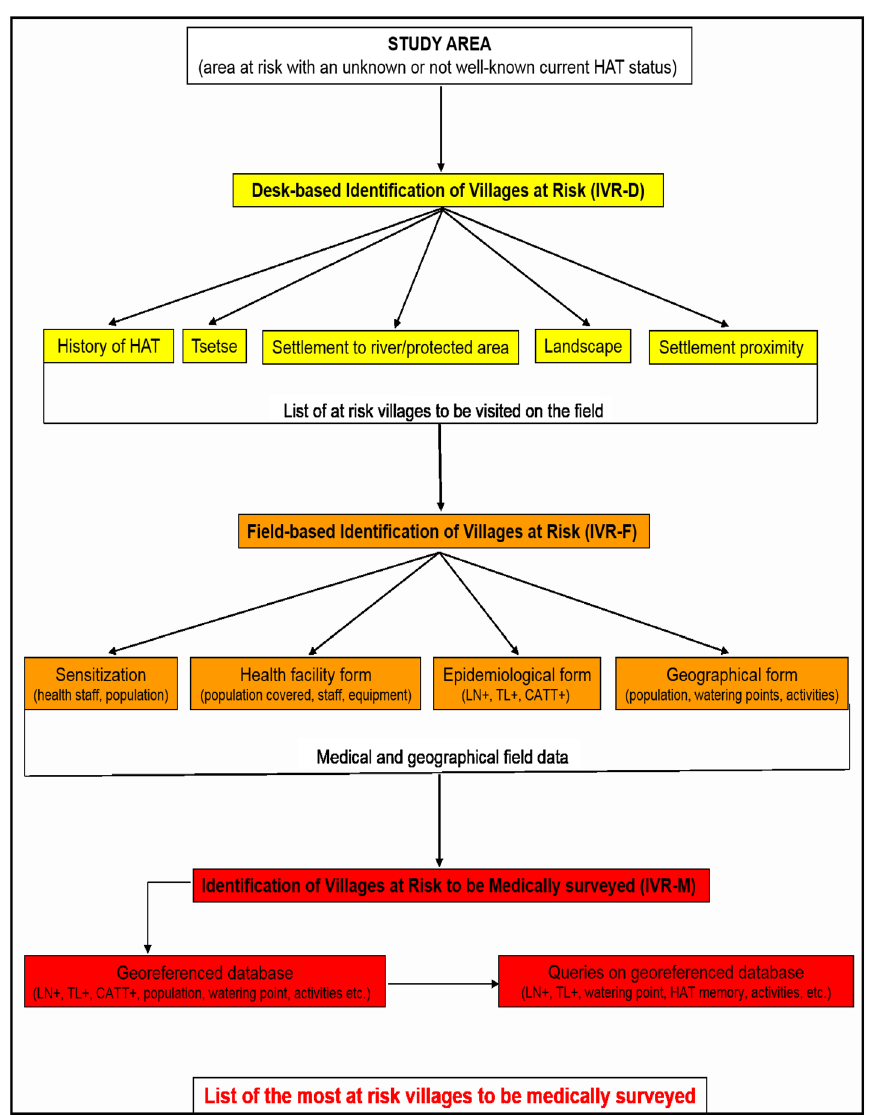
Figure 2. General procedure for IVR. The IVR strategy is structured into three main steps. The fi rst step corresponds to IVR-D, which makes it possible to assemble an initial list of at-risk villages. The second step, IVR-F, is intended to collect fi eld data about the main health facilities and villages on the initial list. The third step involves constructing a geo-referenced database to conduct queries, in order to select the most at-risk villages to be medically surveyed